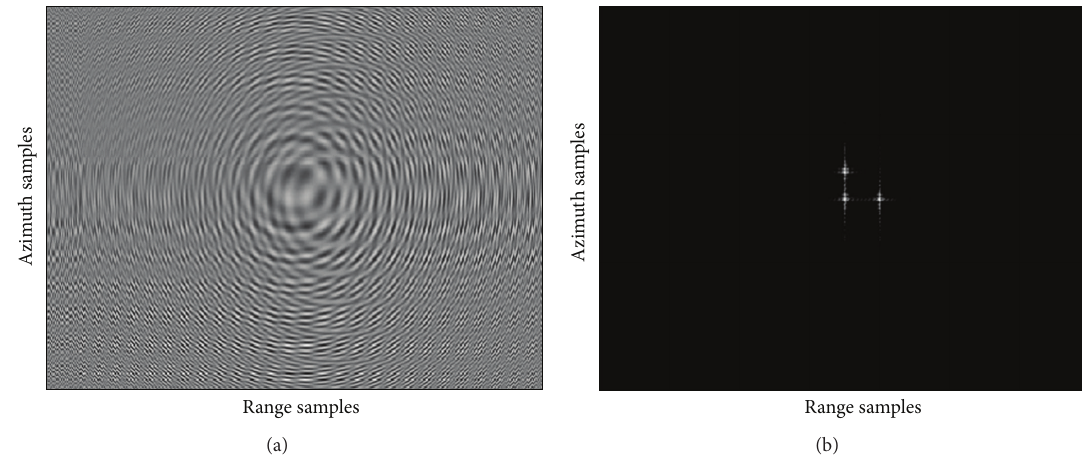
cells, while A and C have the same range cell but different instantaneous Doppler